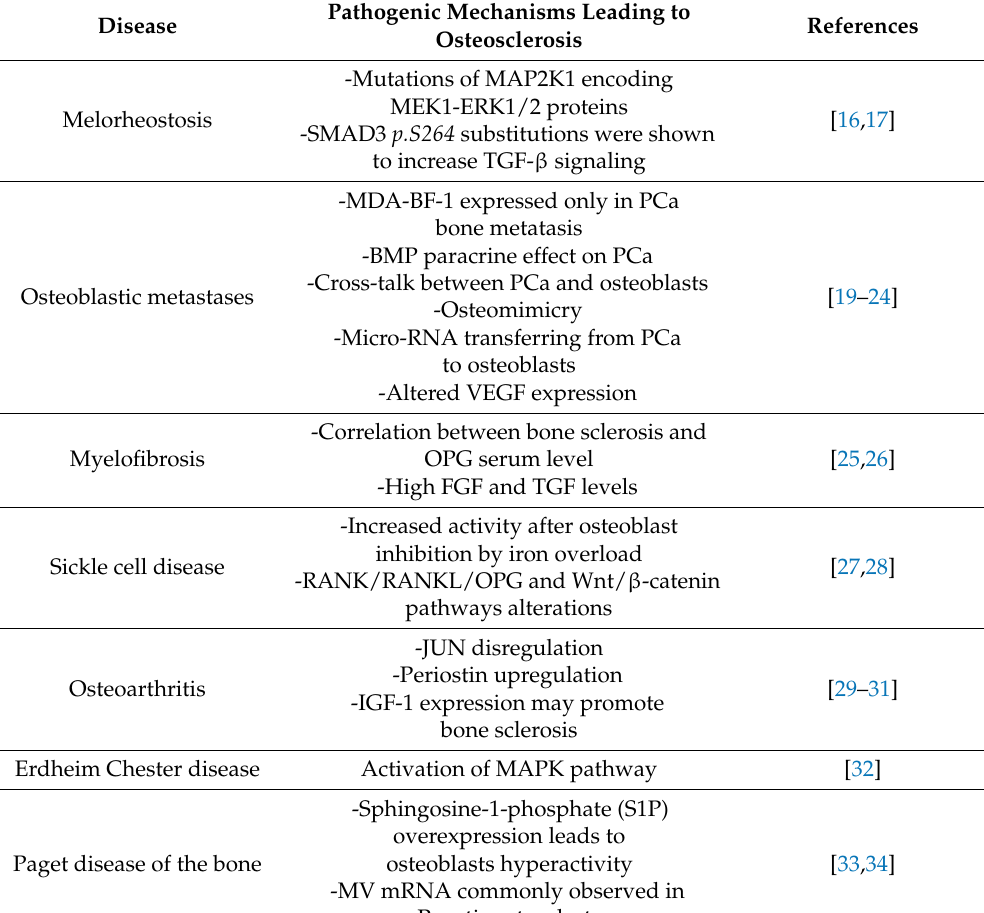
Table 1. Pathogenic mechanisms, hypothesis or evidence defining osteosclerosis in non hereditary sclerosing bone